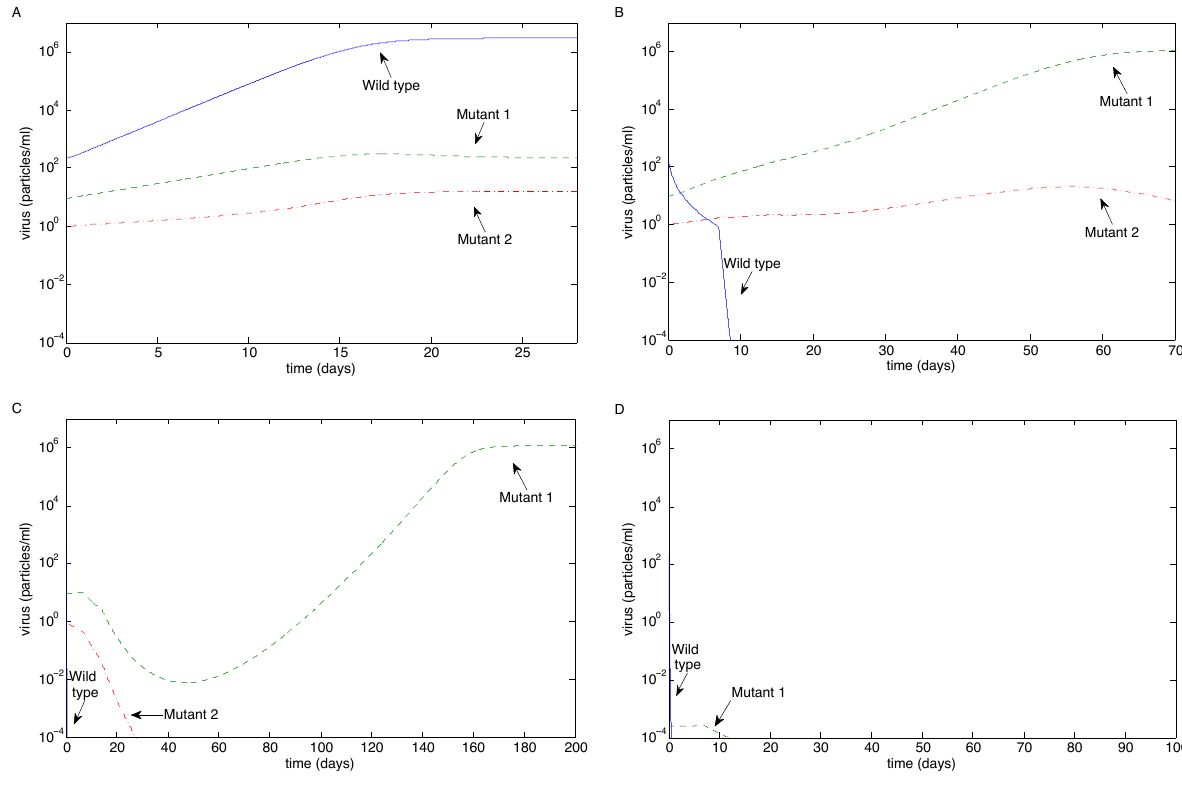
Figure 5. The long-term outcome using the sample values in Table 1 for the case when both mutants have 100 -fold resistance ( p magnification factor m varies. ( A ) m = 1 ; ( B ) m = 10 ; ( C ) m = 50 ; ( D ) the same as (C), except with no initial